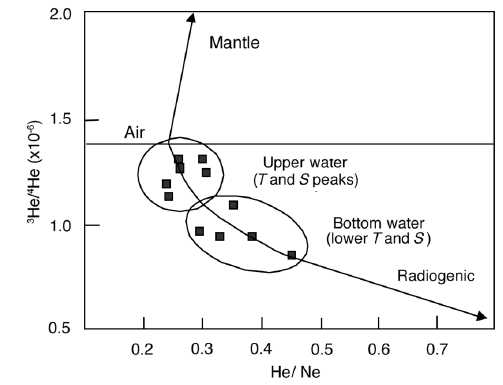
Fig. 5. Helium isotope ratio versus He/Ne. The plot indicates two different waters probably linked to the different water masses whose interface oscillates pro- ducing T / S peaks. The isotope ratio of 1.4 × 10 − 6 is that of the atmosphere. Samples closer to this ratio indicate major atmospheric signal (shallower water). Lower ra- tios are along the mixing line with crustal (radiogenic) sources, and this can be indicative of bottom water, closer to seafloor, with higher residence time.